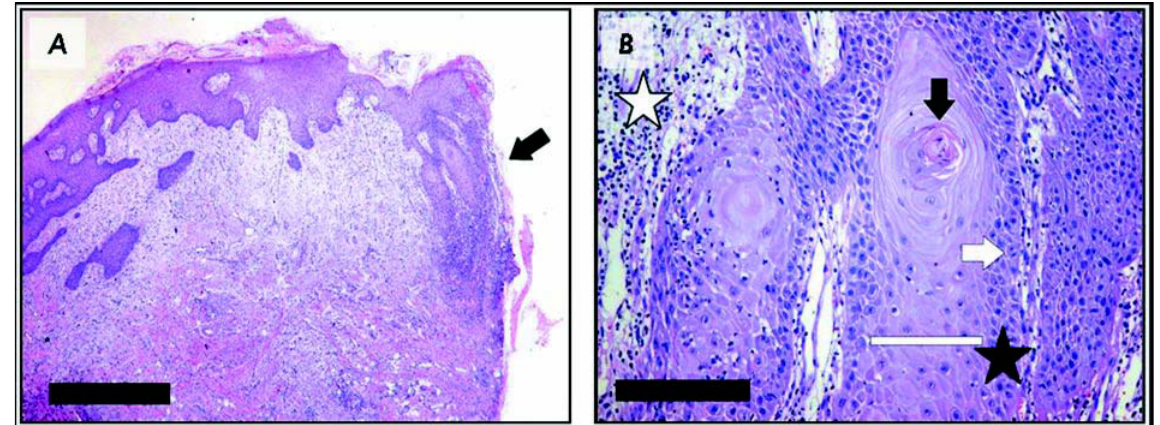
FIGURE 2- Representative aspects of the histological features observed in the initial biopsy. A Low-power view of the tissue section presenting epithelial proliferation and apparent invasion of the lamina propria in one of the fragment borders (arrow). [Hematoxylin-eosin stain, scale-bar = 1mm] B Detail of epithelial projections observed in the specimen presenting acanthosis (white bar), abrupt keratin pearl formation (black arrow), mild cellular pleomorphism in the basal layer (black star), occasional mitosis (white arrow), and moderate infiltrate by inflammatory cells (white star). [Hematoxylin-eosin stain, scale-bar = 125